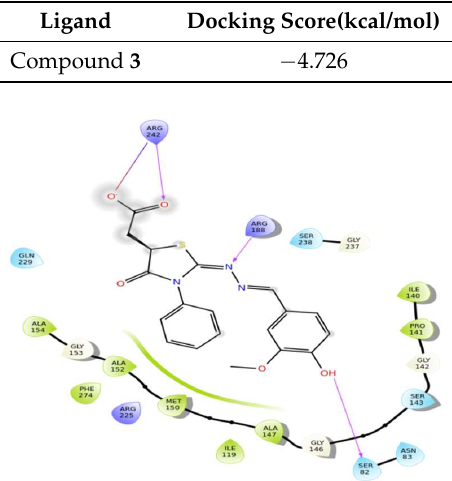
Figure 2. 2D docking pose of Compound 3 in the active site of Staphylococcus aureus MurB enzyme.